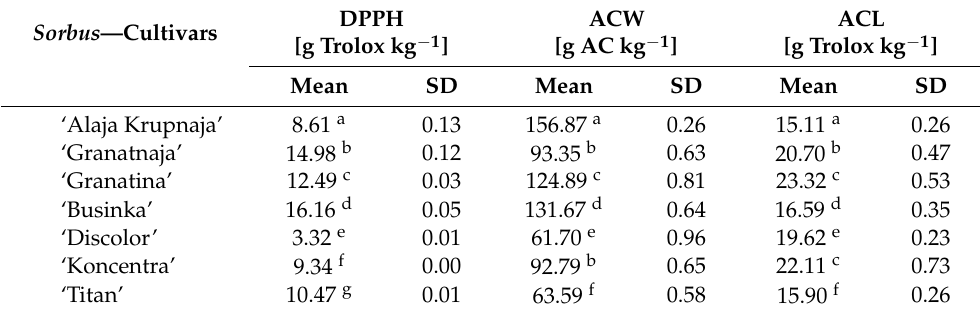
Table 9. Antioxidant activity determined by DPPH [g Trolox kg − 1 ], ACW [g AK kg − 1 ] and ACL [g Trolox kg − 1 ] in the selected Sorbus